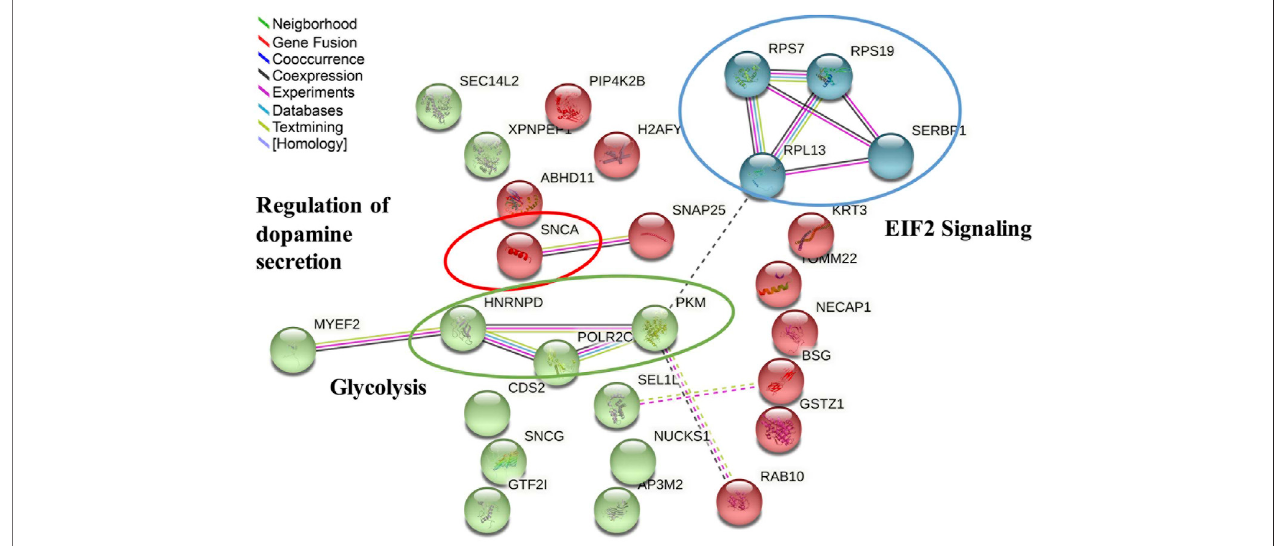
FIGURE8| Protein – proteininteractionanalysisof29signi fi cantlyregulatedproteinsinresponsetoatropinetreatmentfoundbytheSTRINGdatabaseafterkmeans clustering, including 27 matched nodes (gene names) and 14 edges (predicted functional associations). Key molecular functions are circled and named in the network analysis. The three main interaction clusters are colored in red, green, and blue after use of the K-Means clustering algorithm.